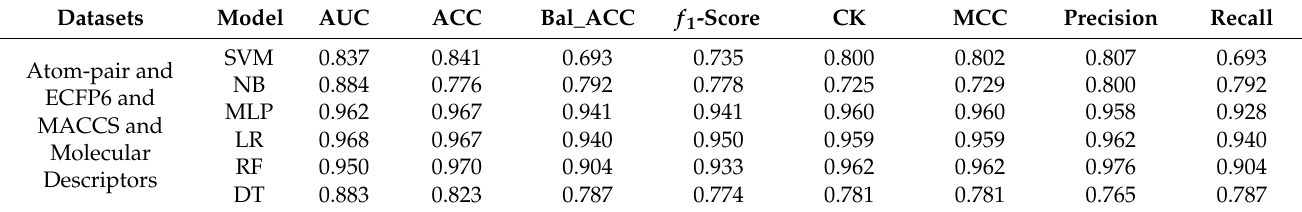
Table 4. Results of the Test Set on Dataset with Four Feature